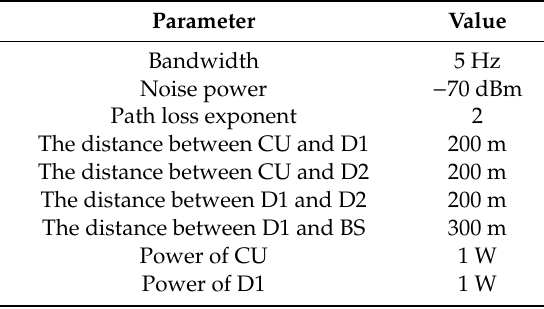
Table 1. Simulation